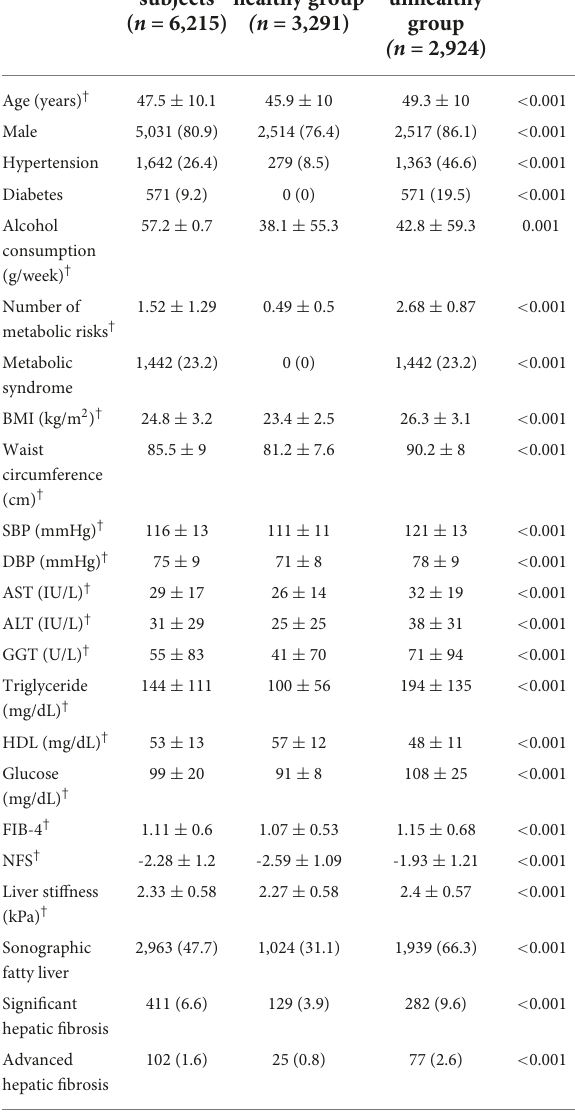
TABLE 1 Baseline characteristics of the average-risk population according to metabolic